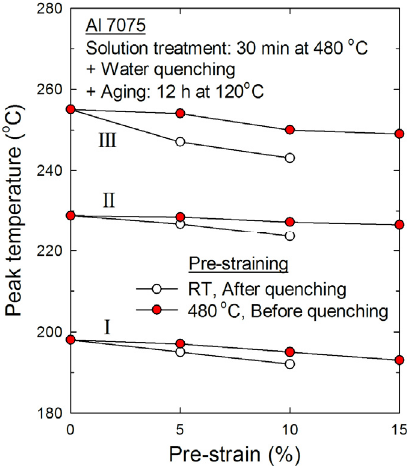
Figure 9. The peak reaction temperatures for separate precipitation reaction stages I–III with the amount of pre-strain at 480 °C and RT on the Al 7075.